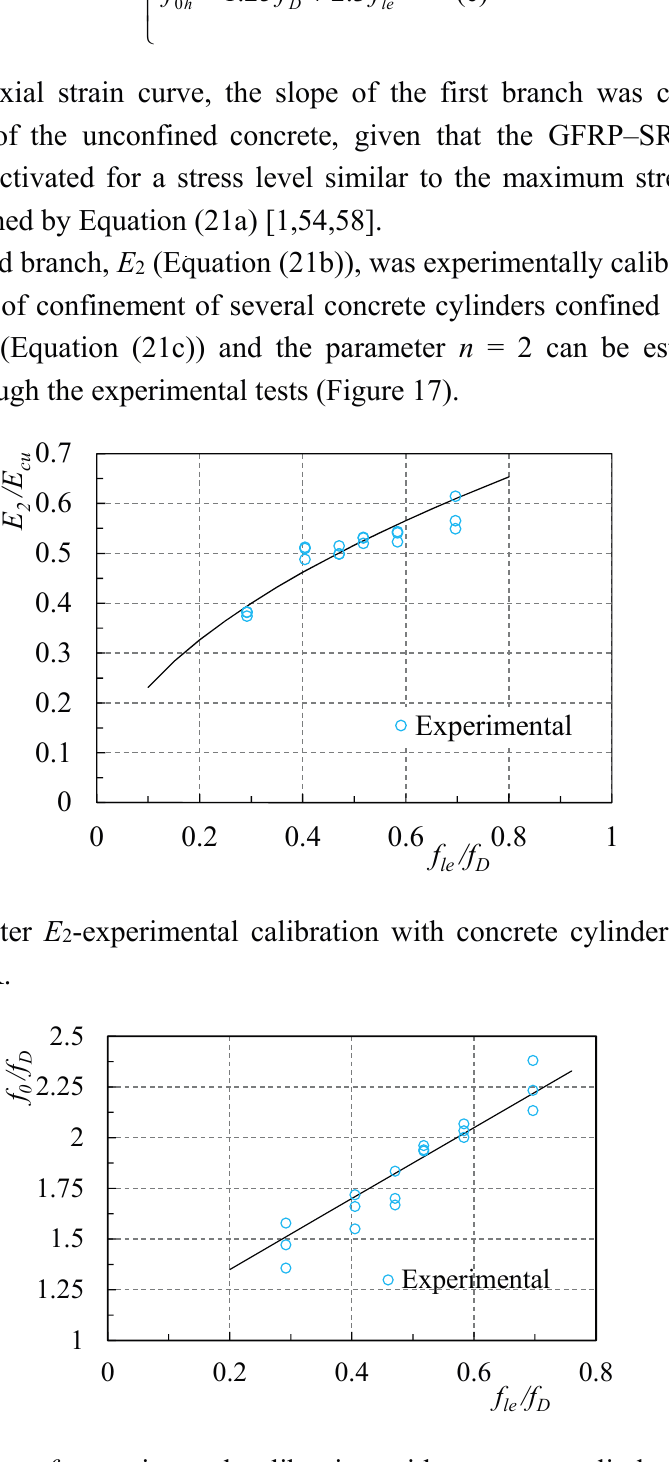
Figure 17. Parameter f 0 -experimental calibration with concrete cylinders confined with GFRP tubes and